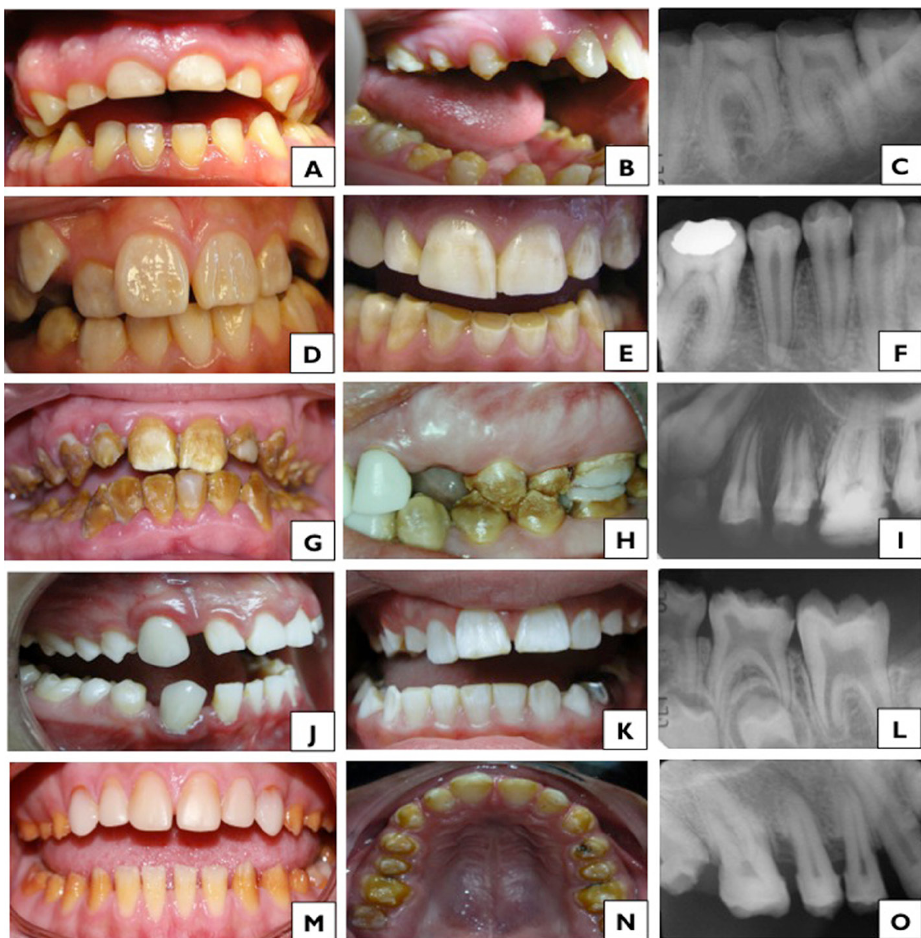
Figure 2- Clinical subtypes of Amelogenesis Imperfecta found in this study; A, B, C: Clinical subtype of Hypoplastic Amelogenesis Imperfecta; D, E, F: Subtype of Hypomature AI; G, H, I: Subtype of Hypocalcified AI; J, K, L: Subtype of Hypomature-hypoplastic AI; M,